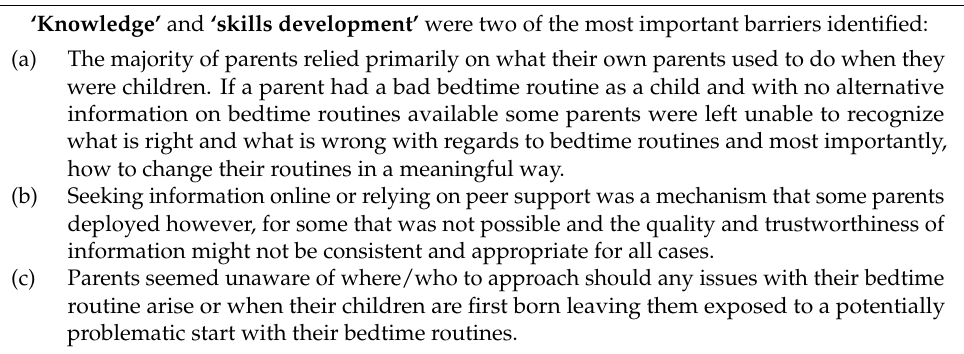
Table 2. Key barriers and facilitators identified